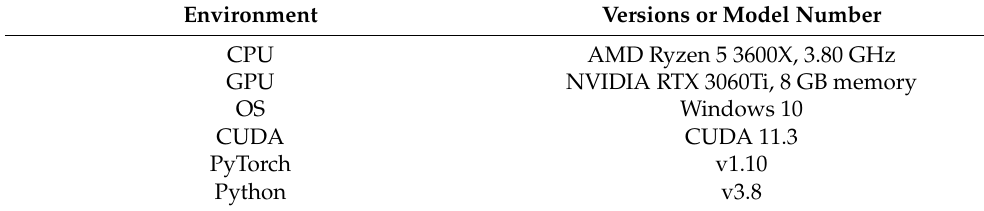
Table 2. Experimental